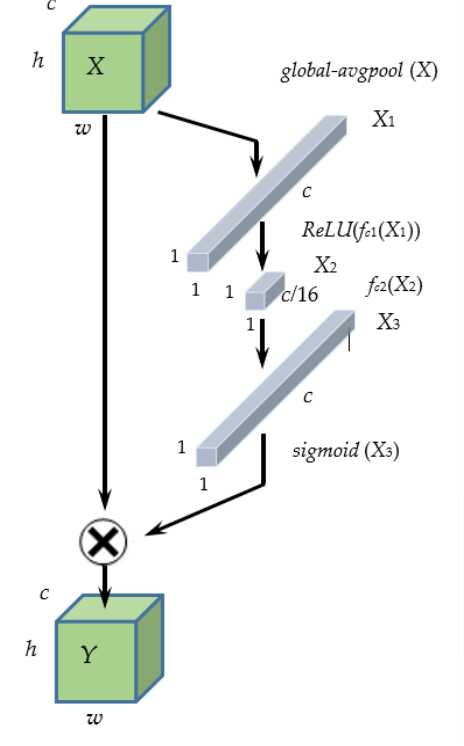
Figure 9. The branch structure diagram of self-attention mechanism.